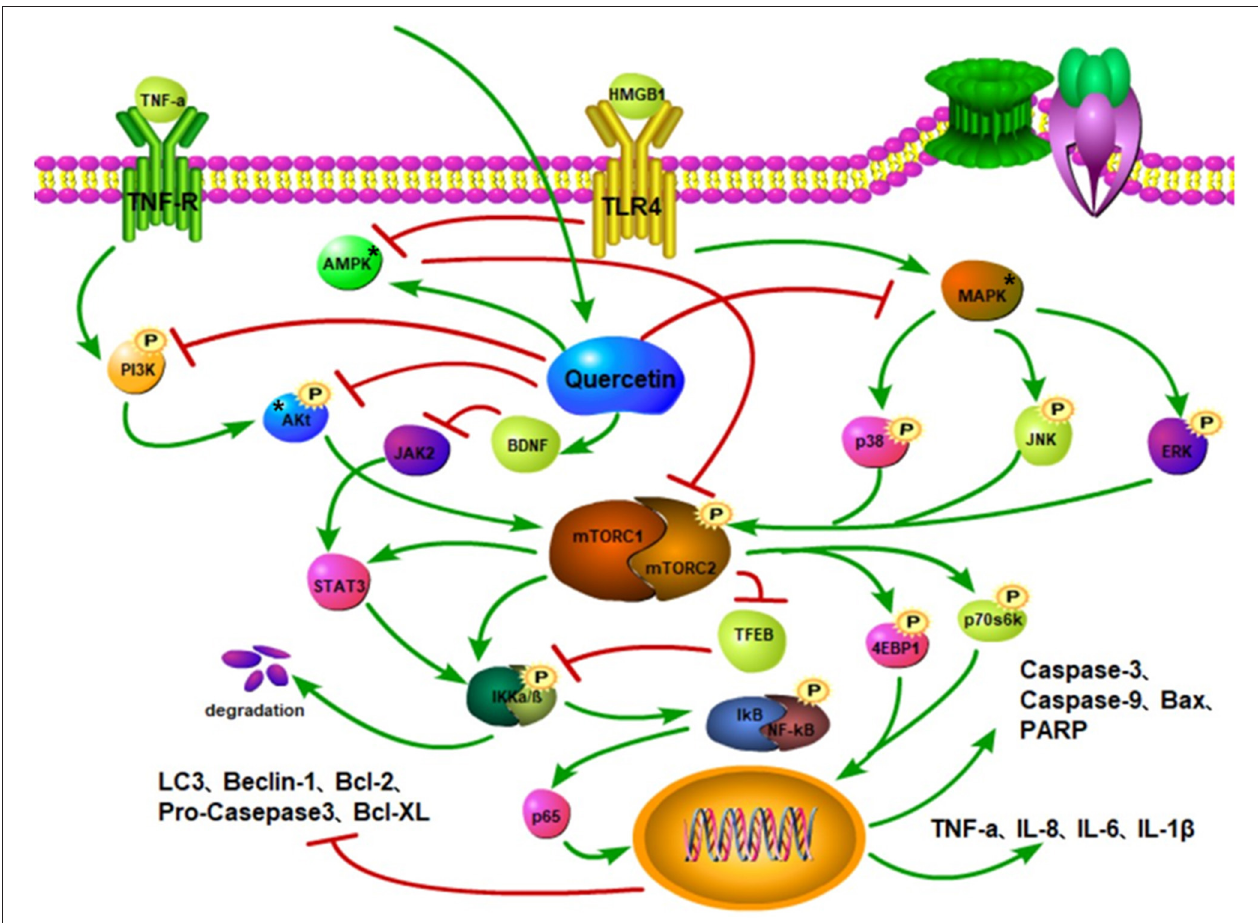
FIGURE 4 | Quercetin inhibits the phosphorylation of PI3K and Akt and mitigates the activation of mTOR. Quercetin activates the AMPK to inhibit mTOR activation and stimulate autophagy. Quercetin suppresses the MAPK activation to curtail the phosphorylations of p38, JNK, and ERK, thereby reducing mTOR activation, while also increasing the ratio of LC3-II and autophagosomes. It also restricts BDNF to inhibit JAK activity and STAT3 activation. The inhibition of the mTOR activity reduces the activations of STAT3 and IKK α / β to promote the TFEB expression. The phosphorylations of I κ B and NF- κ B complexes attenuate the nuclear translocation of p65 and downregulate the expressions of pro-inflammatory factors, such as TNF- α , IL-8, and IL-6. Quercetin downregulates Bax, caspase-9, and caspase-3 protein expressions, inhibits the phosphorylations of Akt, mTOR, P70S6K, and 4E-BP1, and increases Beclin1, Bcl-2, and LC3-II protein levels through the PI3K/Akt/mTOR signaling